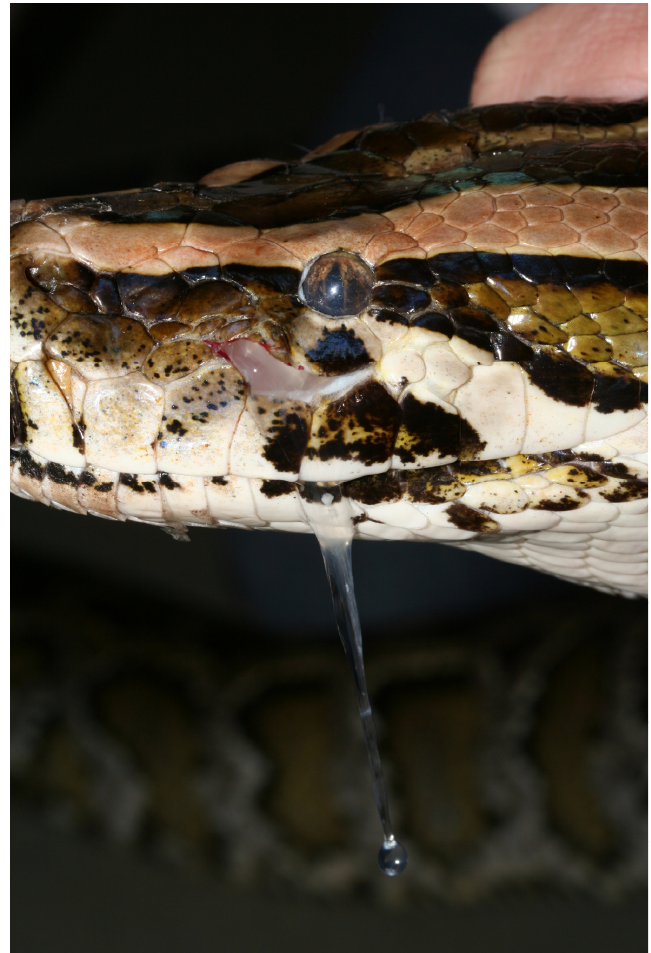
Figure 40. Whenever subspectacular infection of the spectacle has extended to the periocular and/or facial region, making an incision in between the scales is often required to allow drainage and local treatment of the subcutaneous infection.